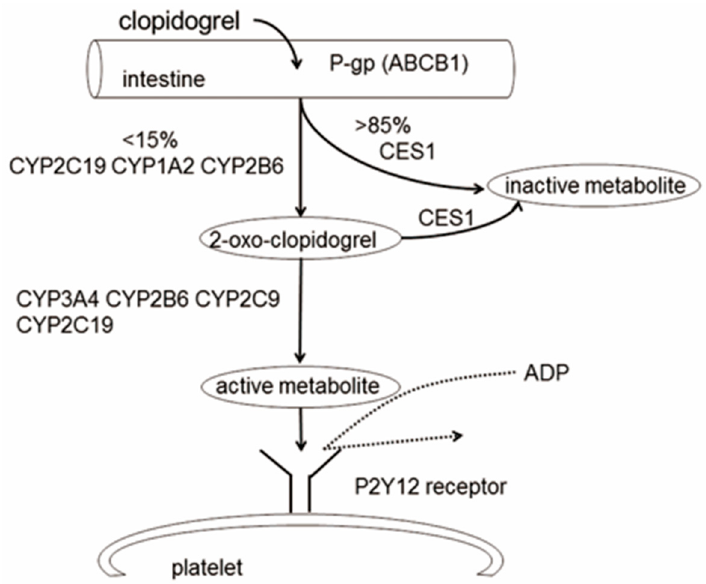
Figure 1. The metabolic pathway of clopidogrel and its targeted receptor. Intestinal absorption of the prodrug clopidogrel is limited by P-glycoprotein (P-gp). After absorption, the clopidogrel (inactive) is oxidized to 2-oxo clopidogrel (still inactive) by CYP450 enzymes. The 2-oxo clopidogrel is then transformed into active metabolites that will bind to P2Y12 receptor on platelet surfaces.